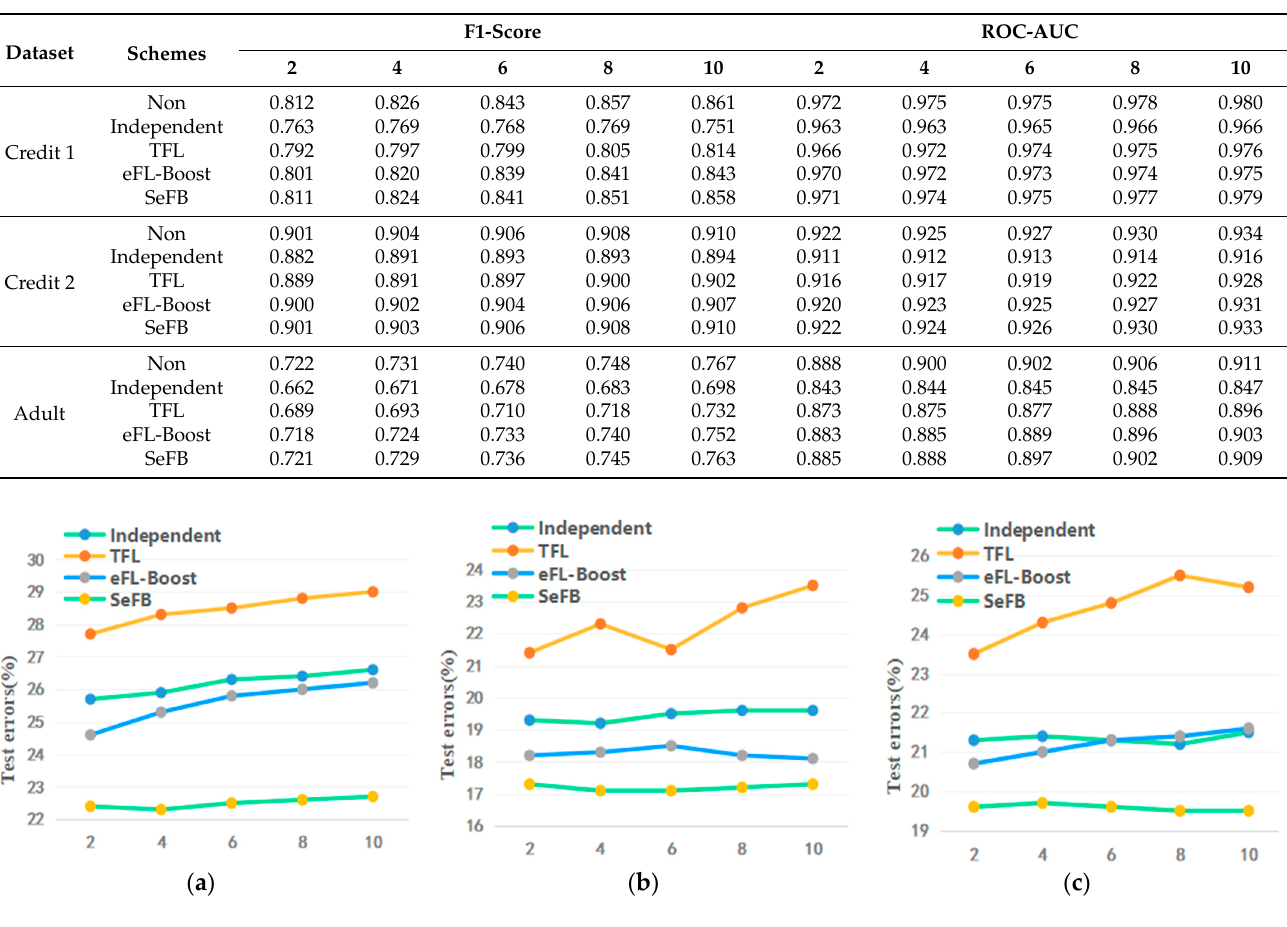
Table 7. Performance impact of participants’ data imbalance ratio.